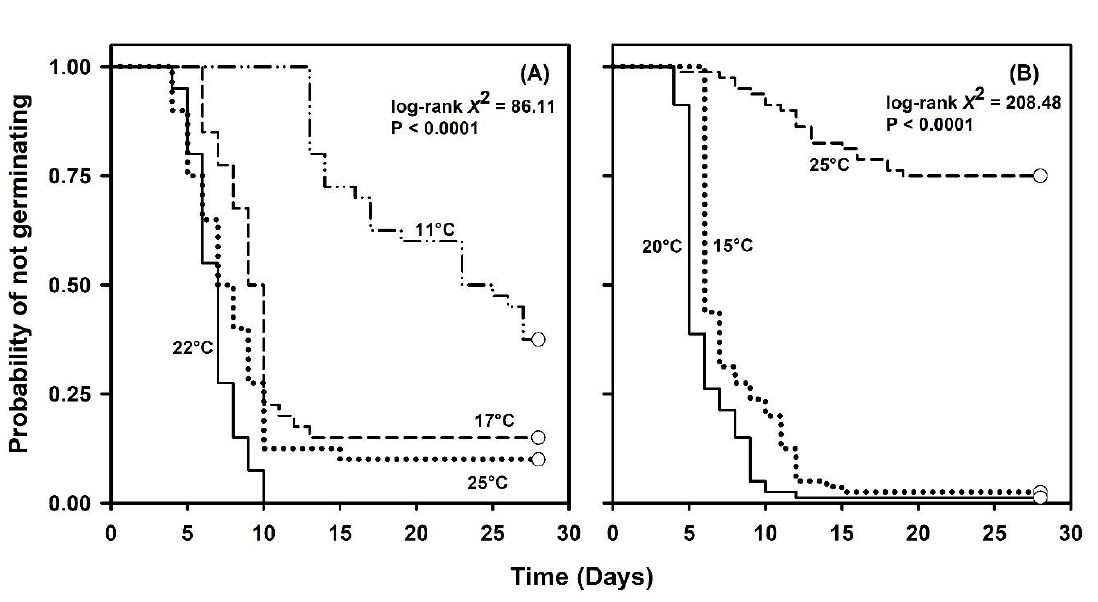
Figure 1. Kaplan–Meier estimates of survivor functions for Linum arenicola seeds exposed to constant temperatures of ( A ) 11, 17, 22, or 25 °C or ( B ) 15, 20, or 25 °C. Pointwise 95% confidence intervals omitted for clarity.